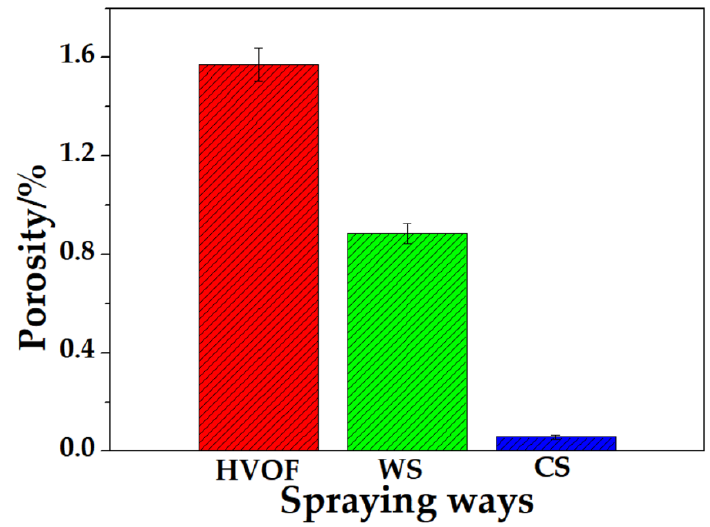
Figure 12. Porosity of WC-17Co coatings formed by various spraying methods.